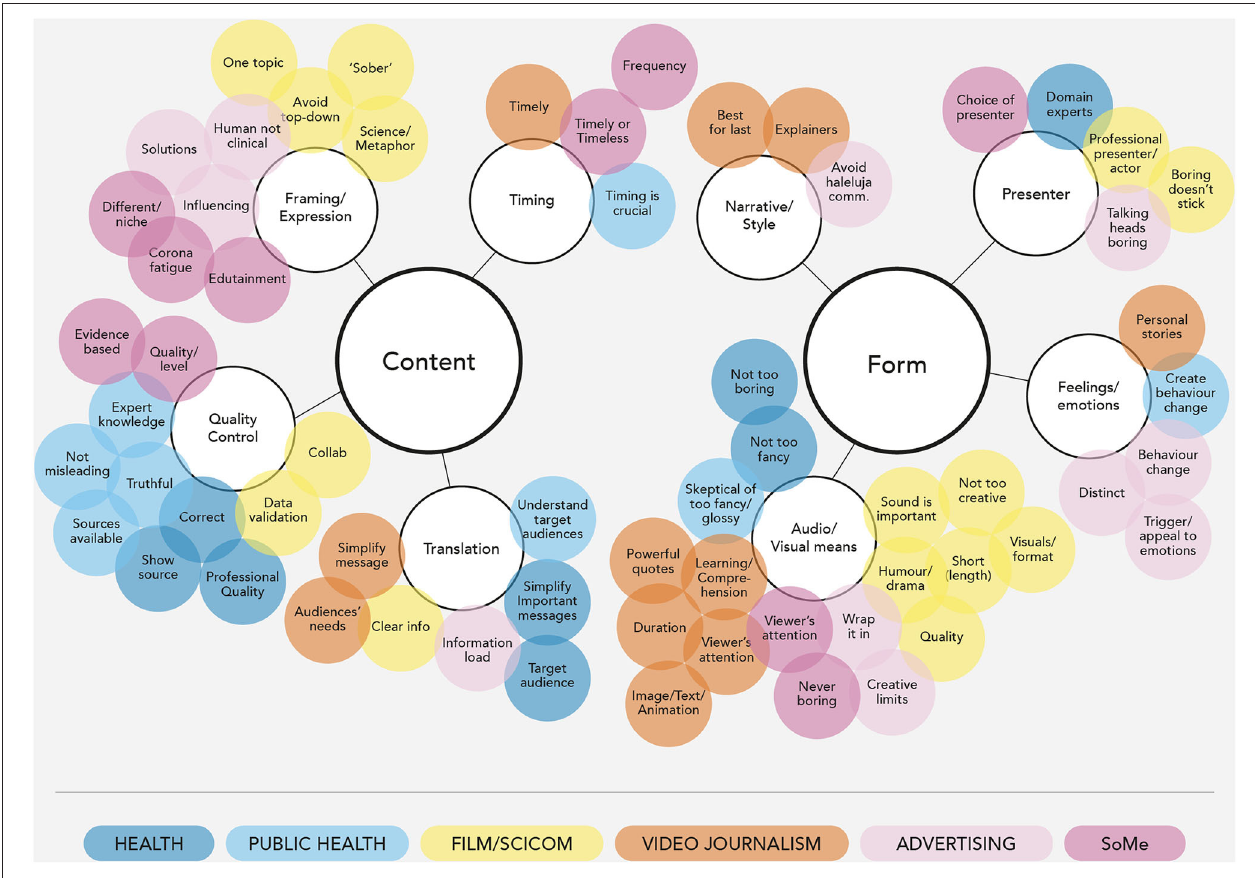
FIGURE 8 | A bubble chart representation of content and form topics deducted from interviews.